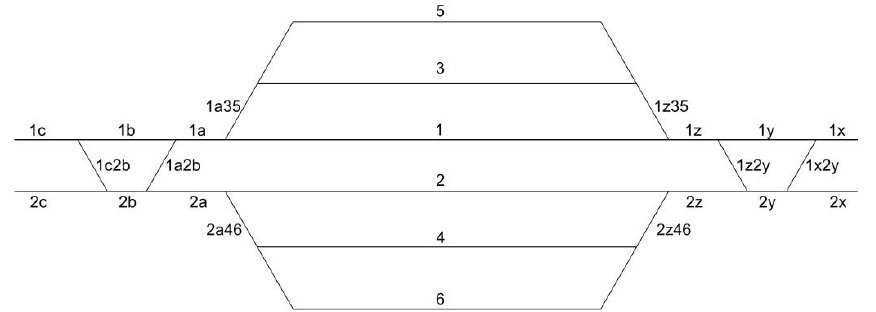
Figure 9. The track layout diagram of Figure 4 divided into sections. Considering vertices 1c2b , 1a2b